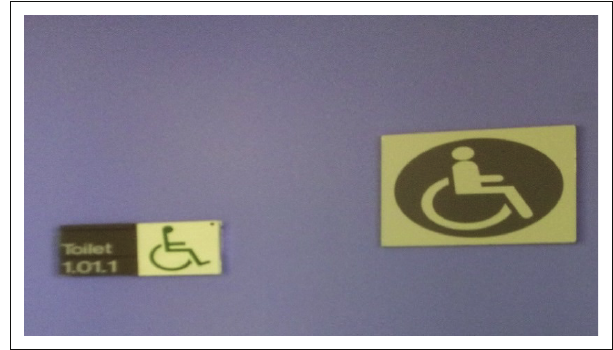
Source : Photo taken by the authors. FIGURE 4: Toilet sections for people with